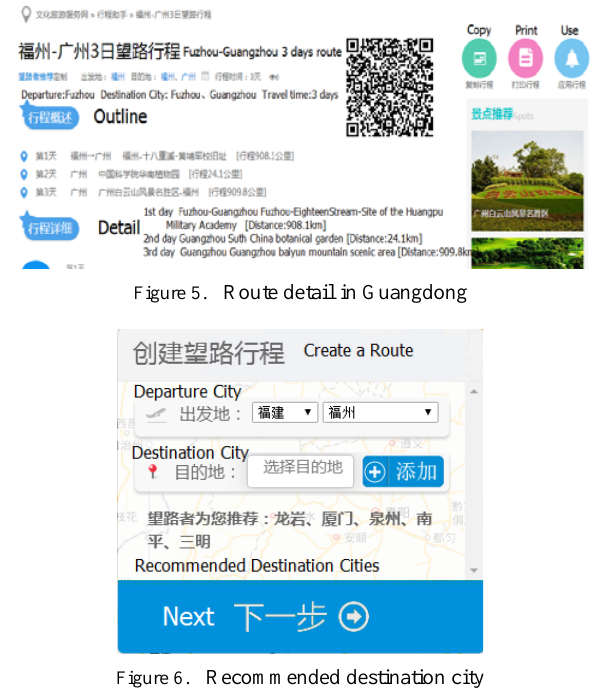
Figure 6. Recommended destination